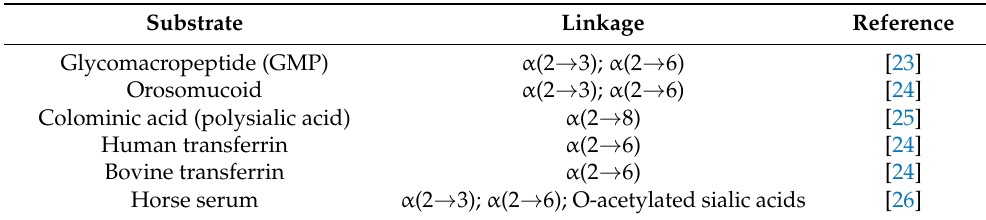
Table 2. Linkages that are attacked by sialidase enzymes in different